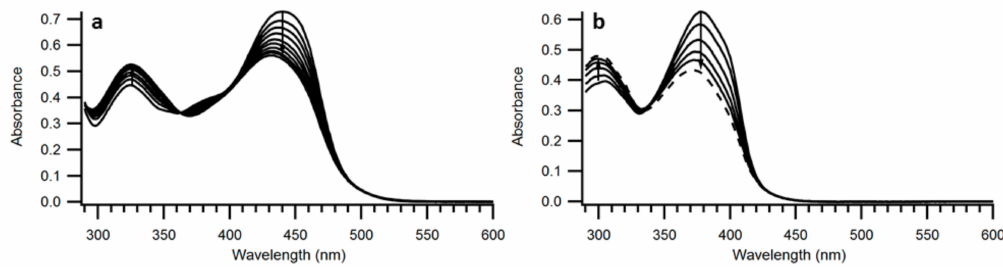
Figure 4. UV-Vis absorption spectra of ( a ) 9 in toluene during irradiation with 440-nm light, ( b ) 10 in toluene during irradiation with 378 nm light.